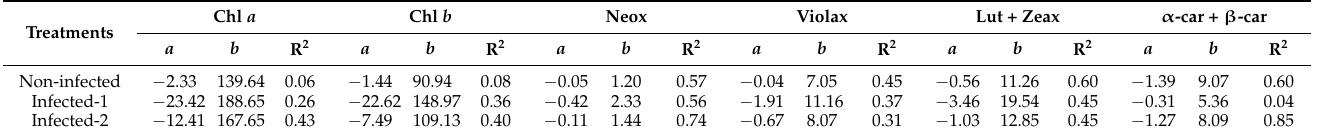
Table 6. Coefficients for linear regression equations presented in Figure 4, in y = ax + b, and their correlation coefficients (R 2